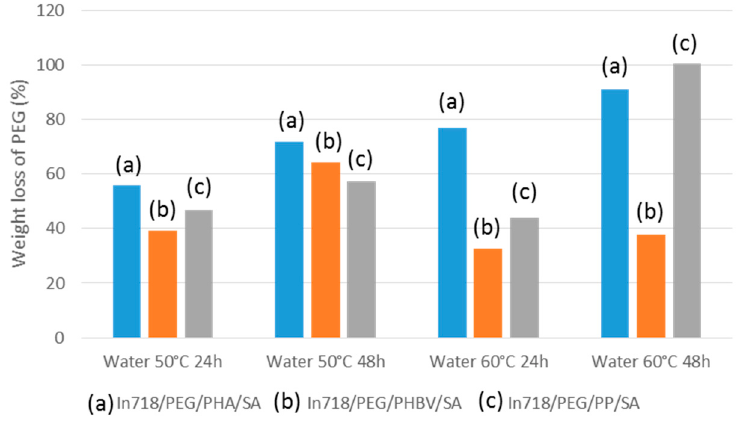
Figure 4. Weight loss of polyethylene glycol (PEG) for the different feedstocks after debinding in water at 50 °C and 60 °C during 24 h and 48 h.